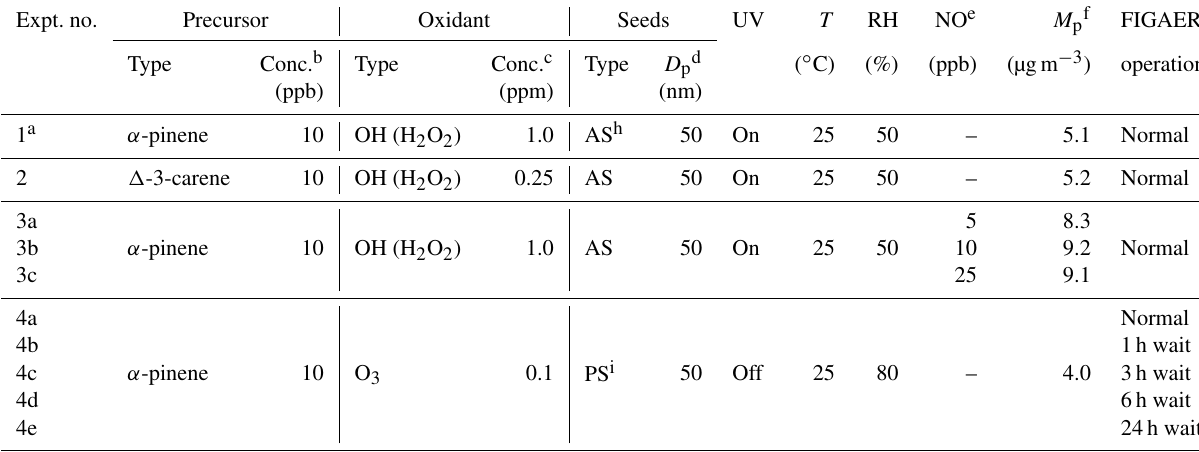
Table 1. Details of SOA formation and chamber conditions for all the example SOA systems. Expt. no.